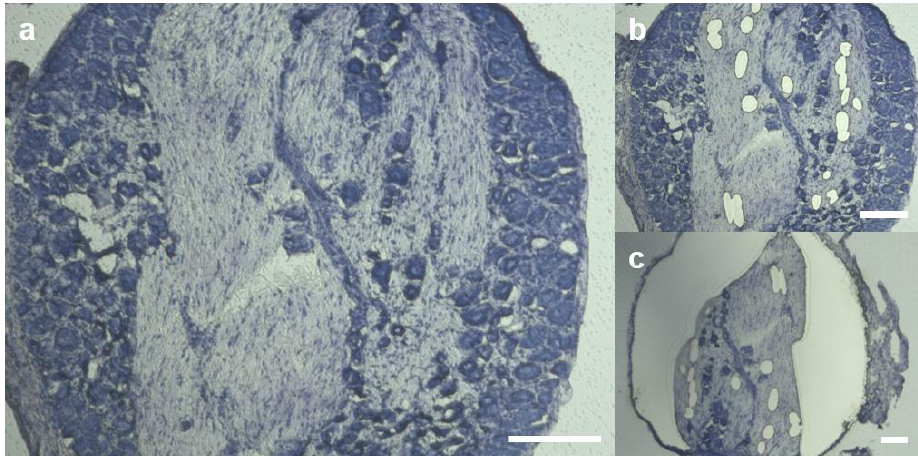
Figure 9. Stepwise sample acquisition of specific rat DRG regions via laser microdissection. Area specific samples of sham operated and rats 1 d after CCI were prepared after toluidine staining. Images of representative sections before dissection ( a ), and after acquisition of vessels in the FRR ( b ) and removal of the NRR ( c ) are shown. Scale bars measure 200 µm.